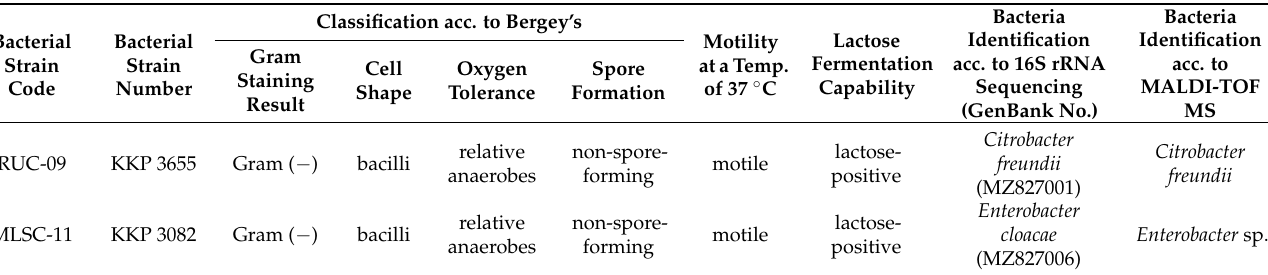
Table 1. Identification of selected bacterial